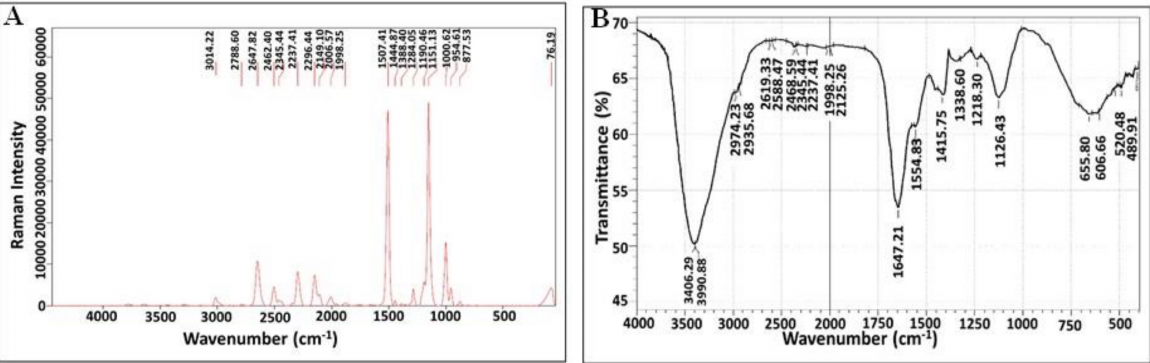
Figure 8. Structural characteristics of carotenoids extracted from halophilic V. halodenitrificans DASH. ( A ) Raman spectra of pigment signal and ( B ) FTIR profile.